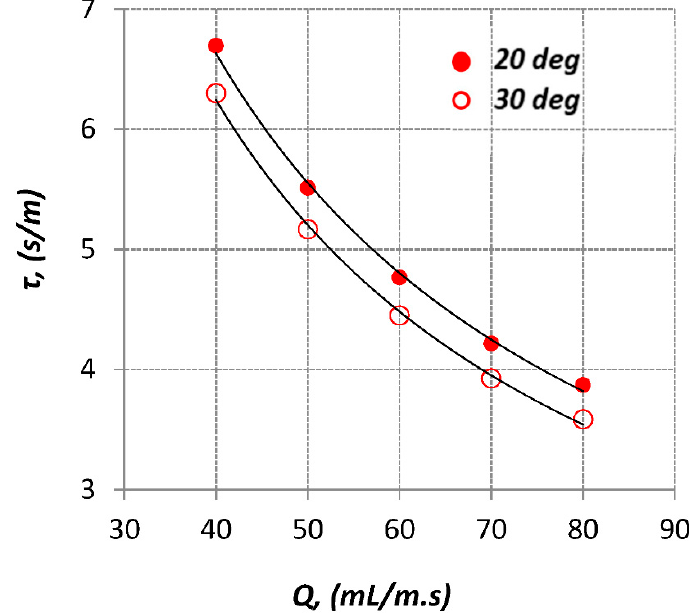
Figure 14. Effect of liquid flow rate and inclination on the residence time (for nW ).